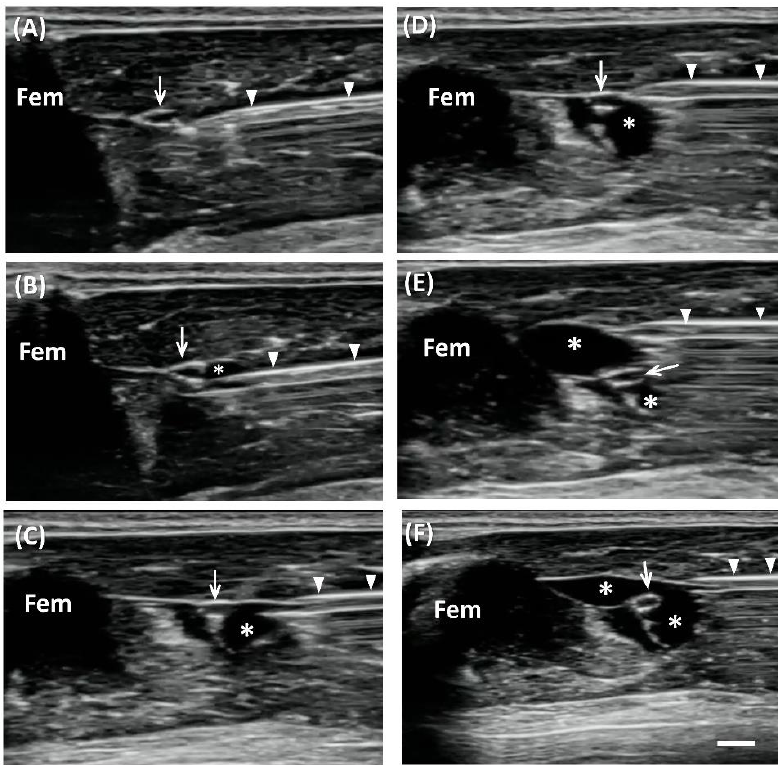
Figure 1. Ultrasound (US)-guided perineural injection of hydrogel. Short-axis view, in-plane ap- proach of US-guided perineural injection of hydrogel (asterisks) showing the insertion of the needle (arrowheads) in the deep regions around the sciatic nerve (arrow) initially ( A – C ), and then superficially ( D – F ) (Fem, femur) (Scale bar: 1 mm).